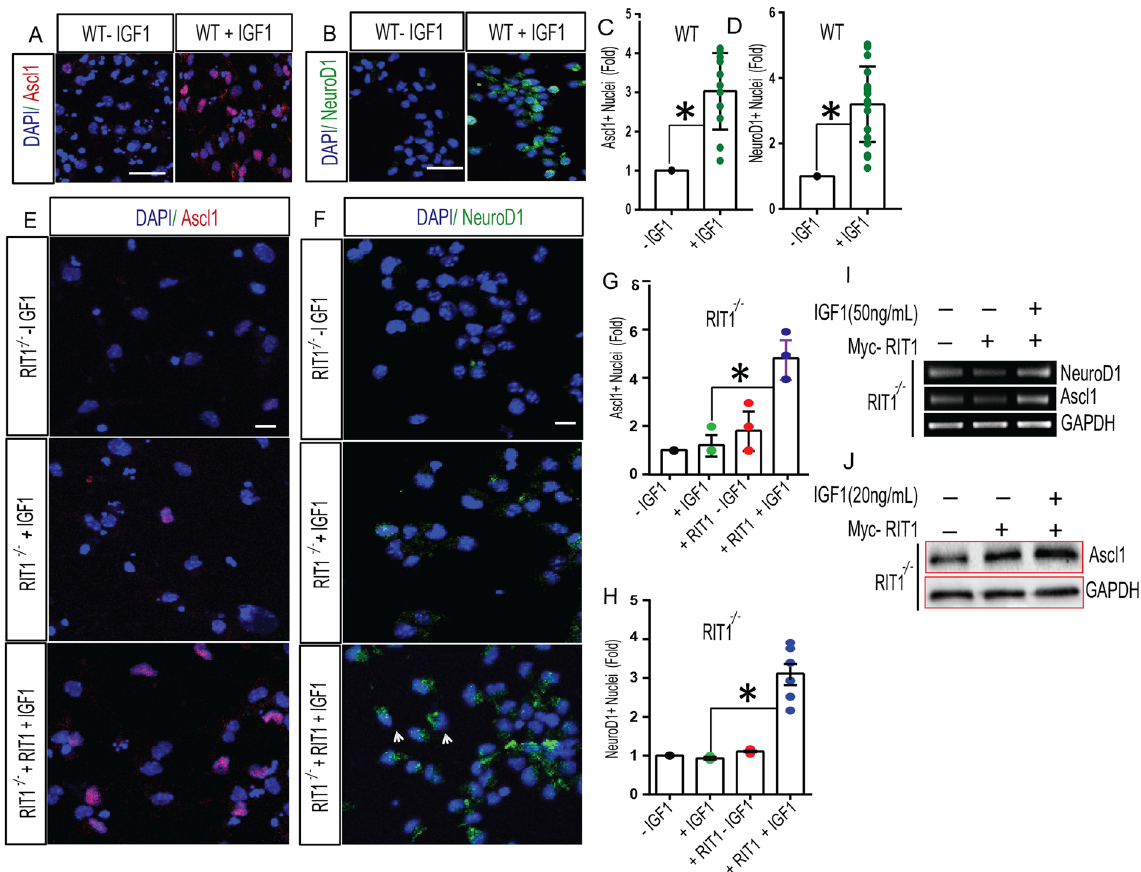
Figure 5. Role for RIT1 in IGF-1-dependent neuronal differentiation. ( A , B ) Representative confocal images of Ascl1 ( red ) and NeuroD1 ( green ) expression in WT HNPCs with or without IGF-1 (50 ng/ml, 24 h) stimulation. Scale bar, 20 μ m. ( C , D ) Quantification (n = 200 cells from 5–6 fields) of Ascl1 + or NeuroD1 + neural precursor cells in WT HNPCs with or without IGF-1 stimulation ( * p < 0.05, nonparametric one tailed t-test). ( E , F ) Representative confocal images of Ascl1 + ( red ) and NeuroD1 + ( green ) cells in RIT1 − / − HNPCs or RIT1 − / − HNPCs following re-expression of Myc-RIT1, with and without IGF-1 stimulation (50 ng/ml, 24 h). Scale bar, 15 μ m. ( G , H ) Quantification of Ascl1 + precursors ( * p < 0.05, one-way ANOVA) and NeuroD1 + neuronal precursors ( * p < 0.05, one-way ANOVA) following RIT1 complementation with or without IGF-1 stimulation. ( I ) Semi-quantitative RT-PCR demonstrates IGF-1-mediated increases in NeuroD1 and Ascl1 expression in RIT1 − / − HNPCs following RIT1 complementation. Representative images of the gene bands were cropped from the original agarose gels. ( J ) Representative Western blot showing RIT1-dependent increase in Ascl1 protein following IGF-1 (20 ng/ml) stimulation of RIT1 − / − HNPCs. Representative images of the protein bands were cropped from the original blots run in parallel. Results are presented as mean ± SEM calculated from three separate